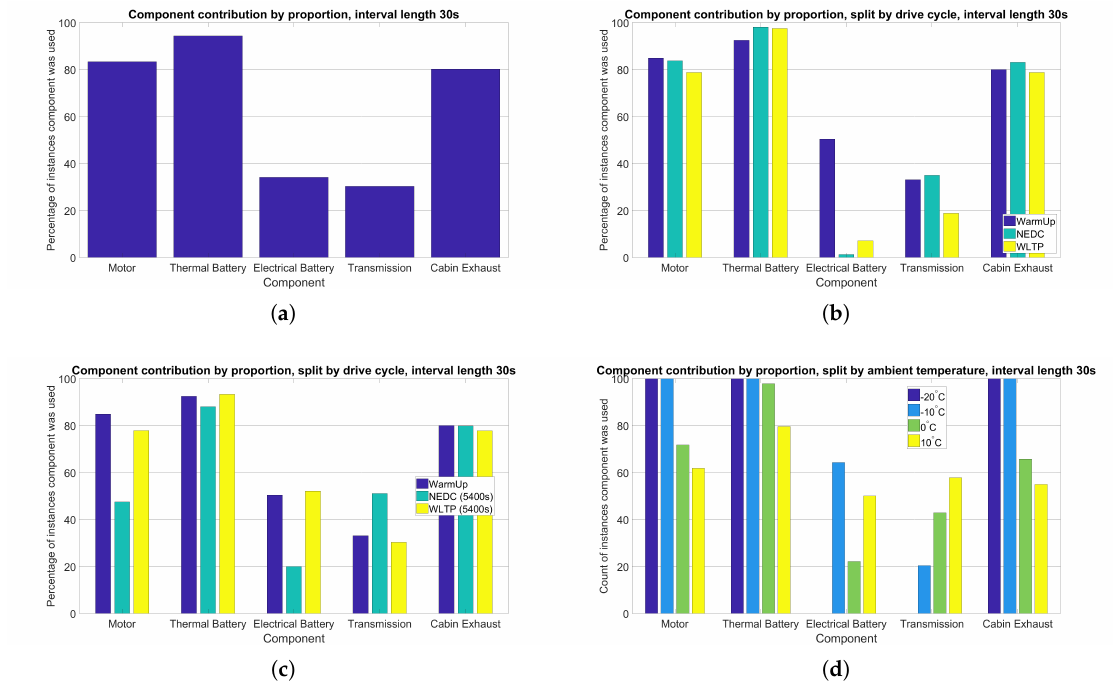
Figure 12. The percentage of instances the best performing operational modes made use of each component across all drive cycles and temperatures. ( a ) shows the contribution of each component over all scenarios, ( b ) shows the contribution of each component split over each of the drive cycles tested, ( c ) shows the contribution of each component split over each of the drive cycles tested (extended to 5400 s), and ( d ) shows the contribution of each component split over the range of temperatures